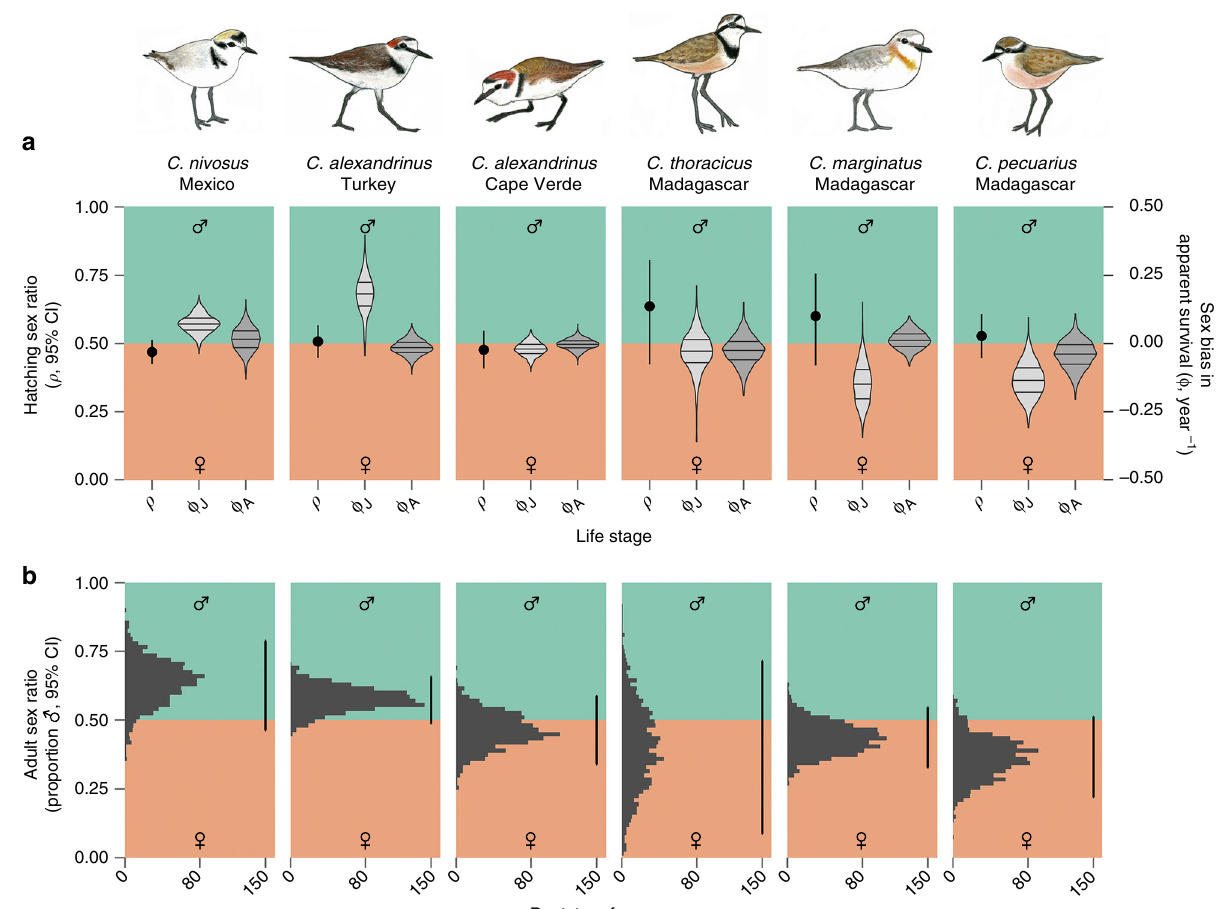
Fig. 2 Inter- and intra-speci fi c variation in sex-biased demographic rates. a Hatching sex ratios of successful clutches (proportion of chicks that are male) are shown as point estimates ( ρ ± 95% CI; left y -axis), and sex bias (i.e. difference between males and females) in annual apparent survival rates of juveniles ( ϕ J ) and adults ( ϕ A ) is shown as violin plots (right y -axis). Horizontal lines within violin plots indicate the median and interquartile ranges of the bootstrapped estimates (see Methods for details). b Bootstrap distributions of the derived ASRs based on the sex- and stage-speci fi c apparent survival rates shown in panel a . Vertical bars on the right side of histograms indicate the 95% CI of ASRs based on 1000 iterations of the bootstrap (mean ASR [95% CI]: C. nivosus = 0.638 [0.464, 0.788], C. alexandrinus [Turkey] = 0.576 [0.487, 0.659], C. alexandrinus [Cape Verde] = 0.463 [0.339, 0.587], C. thoracicus = 0.401 [0.086, 0.716], C. marginatus = 0.434 [0.328, 0.546], C. pecuarius = 0.363 [0.220, 0.512]). Original plover illustrations by